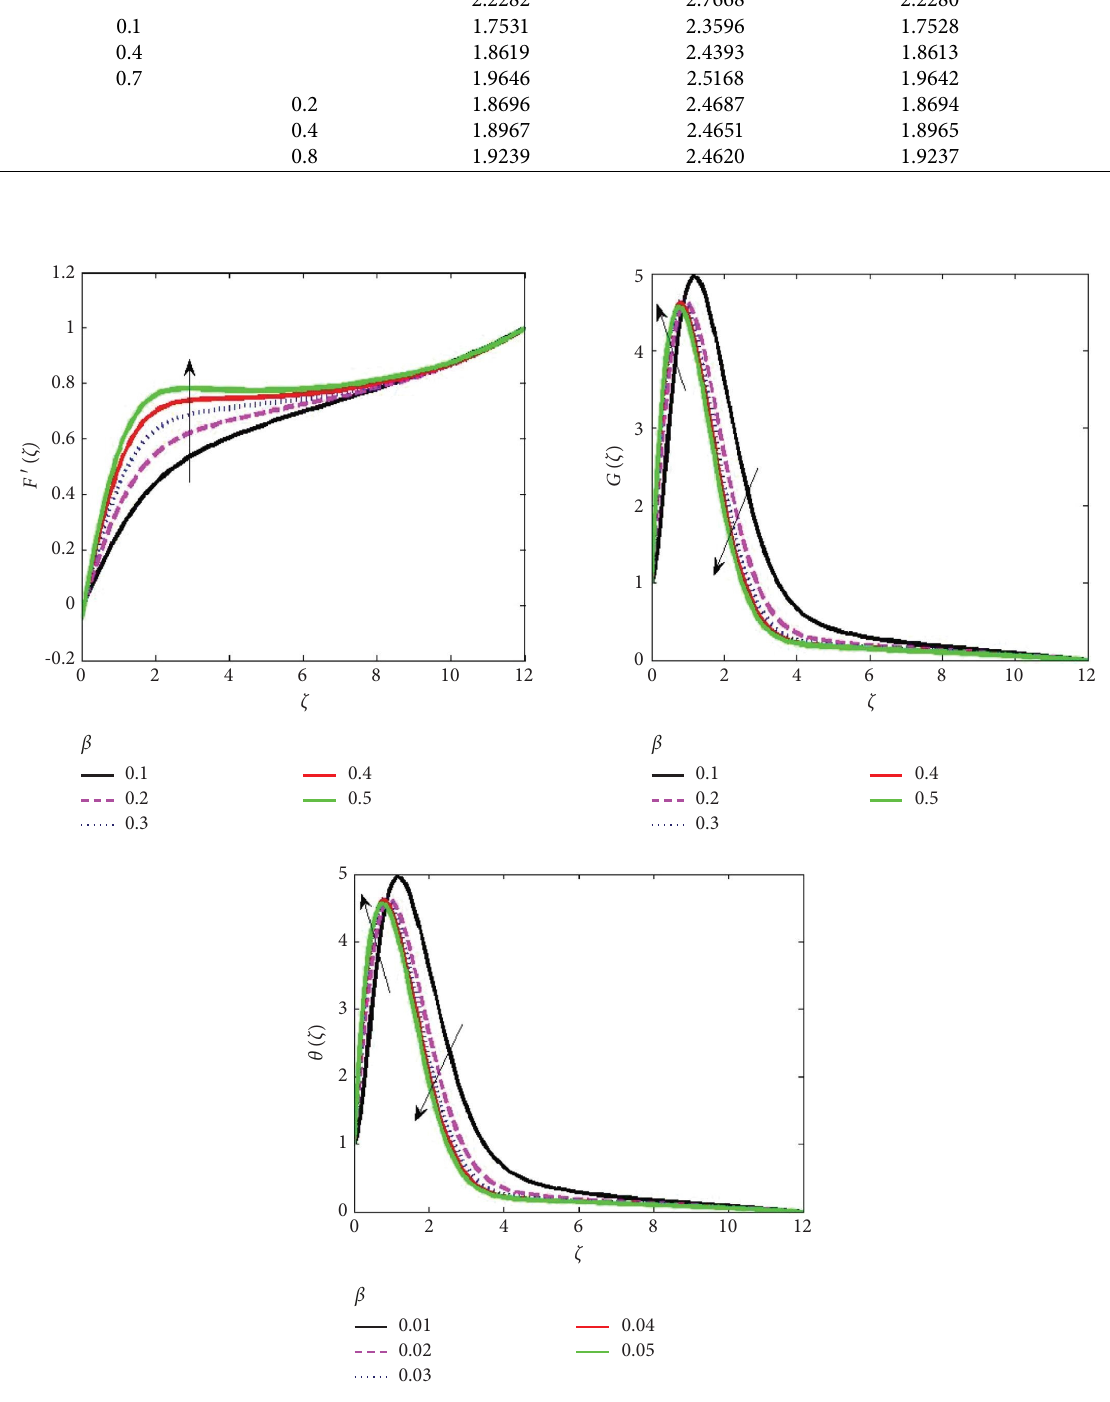
Figure 2: Infuence of Casson parameter on the velocity, azimuthal velocity, and temperature.